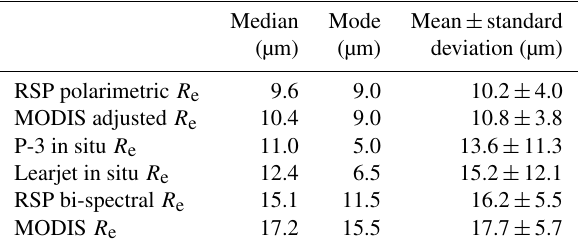
Table 5. R e statistics averaged over all research flight segments for warm clouds. Median